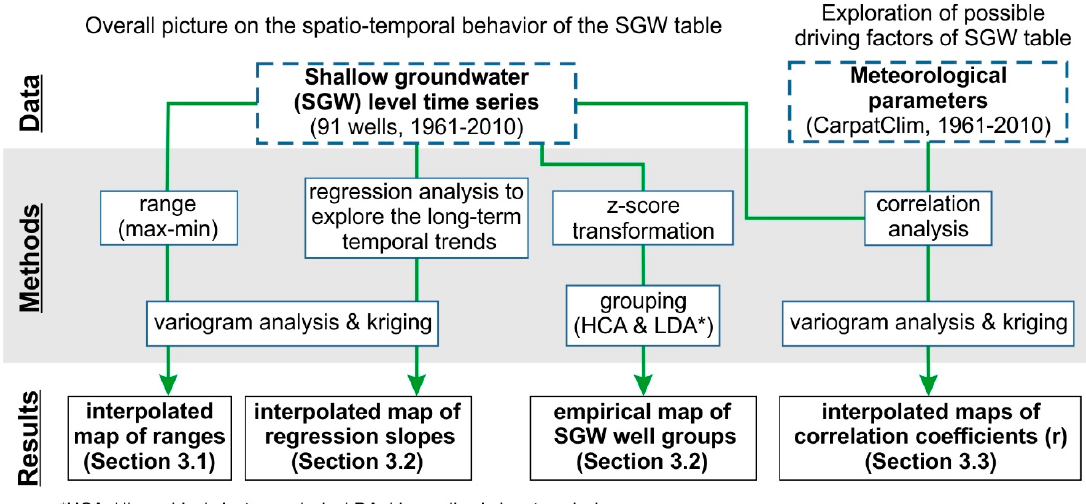
Figure 2. Flowchart of the steps taken in the study.